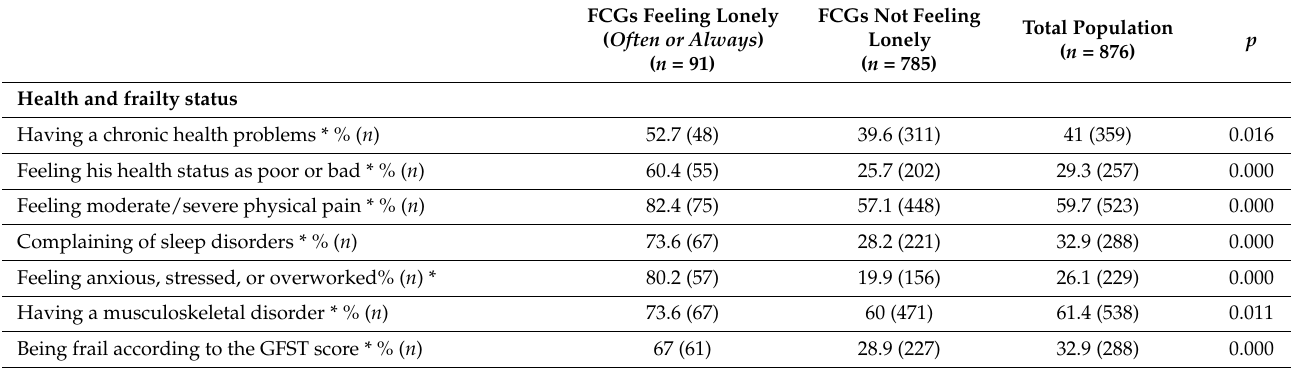
Table 2. FCGs’ health, frailty, and burden